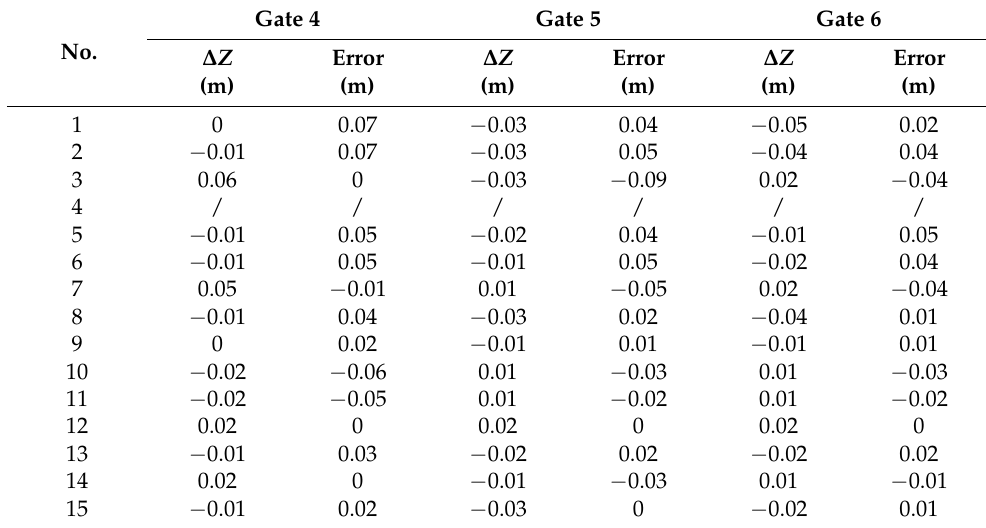
Table 9. Water level difference and predicted error of BSSS.